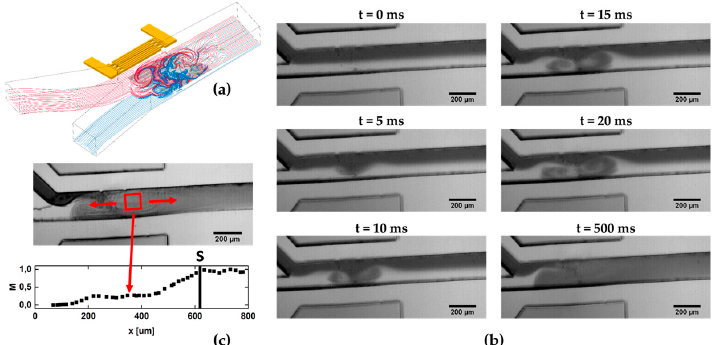
Figure 2. ( a ) Sketch of the principle setup: due to acoustic streaming two solvents are mixed by chaotic advection; ( b ) Time sequence of the mixing process after launching of the SAW; ( c ) Using the measure M for the mixing efficiency, the distance where the fluids are completely mixed are determined in order to estimate an upper limit of the mixing time.